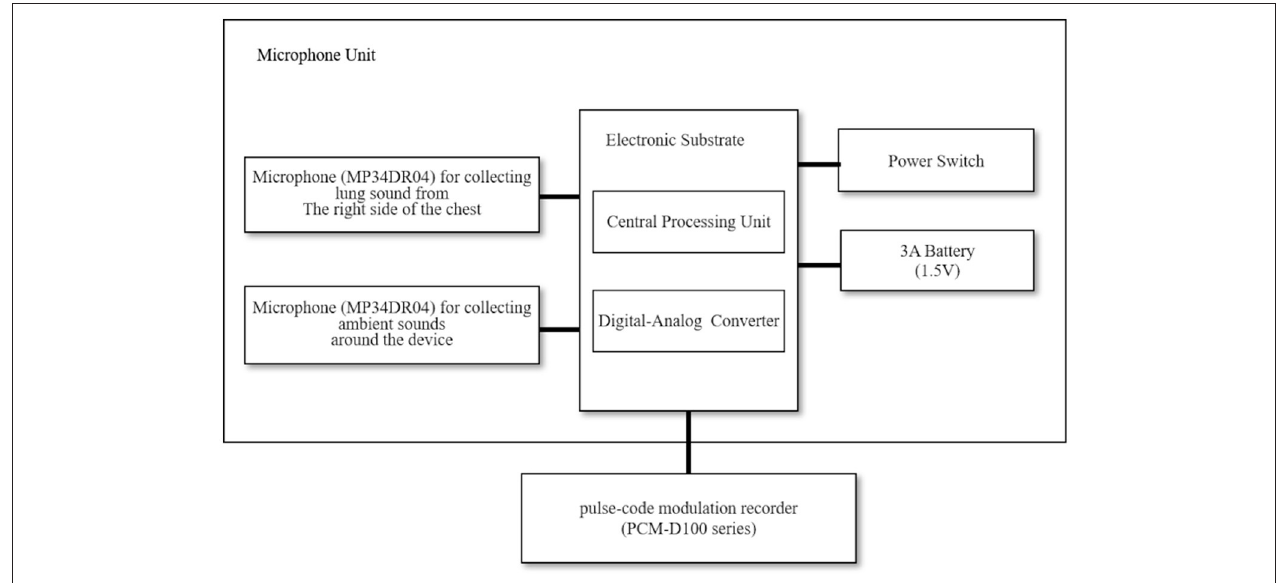
FIGURE 1 | Block diagram showing the equipment used for lung sound